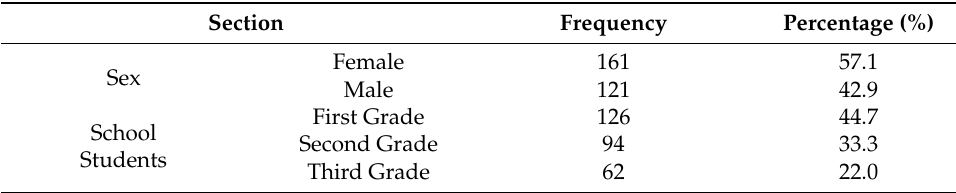
Table 1. General Feature of subject of